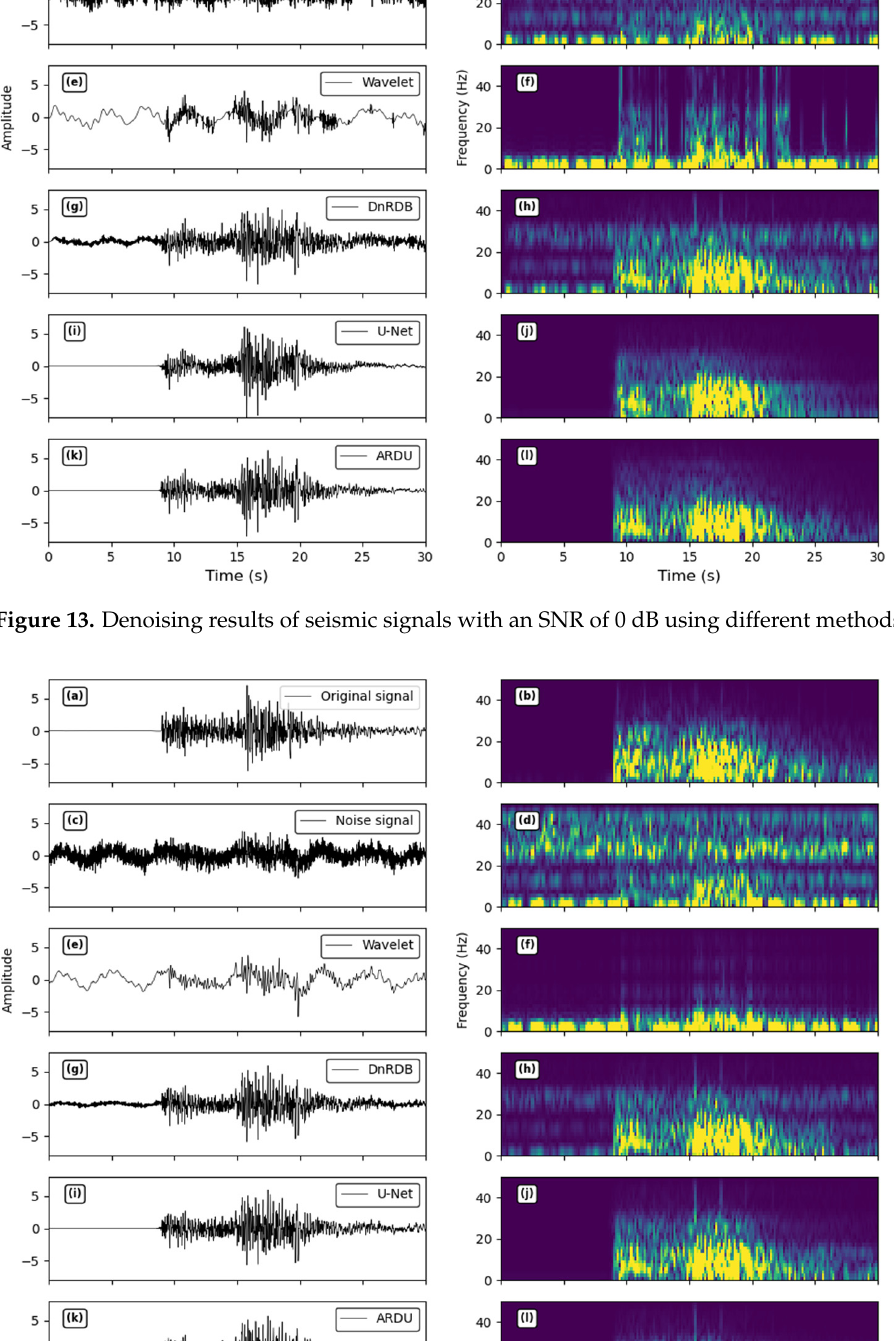
Table 3. Denoising results of seismic signals with an SNR of 6 dB using different methods.